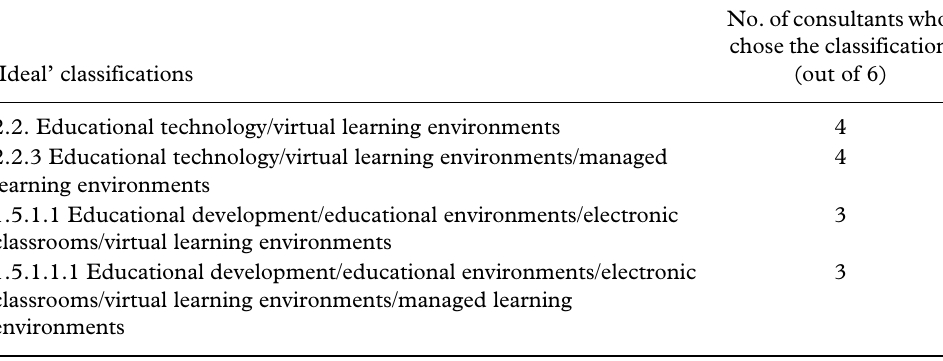
Table 2. Overlap between classifications chosen by consultants